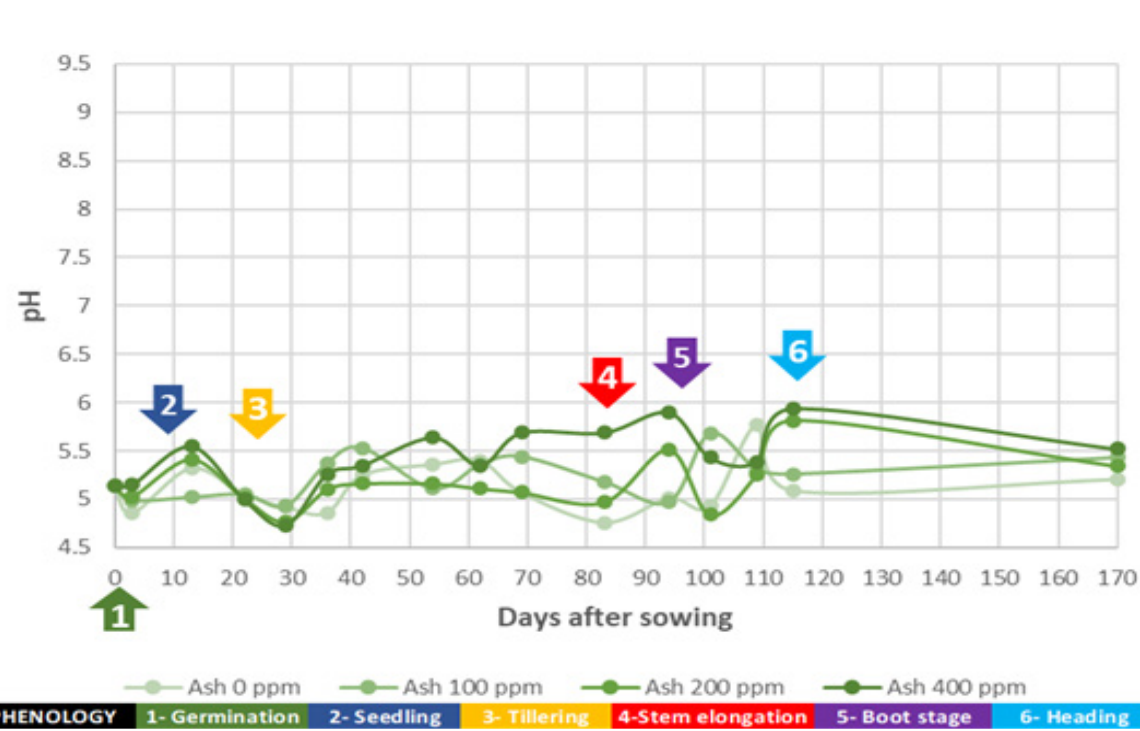
Figure 4 . Fluctuation of soil pH for all rice husk ash treatments (Ash Xppm) during the field stage of the experiment.